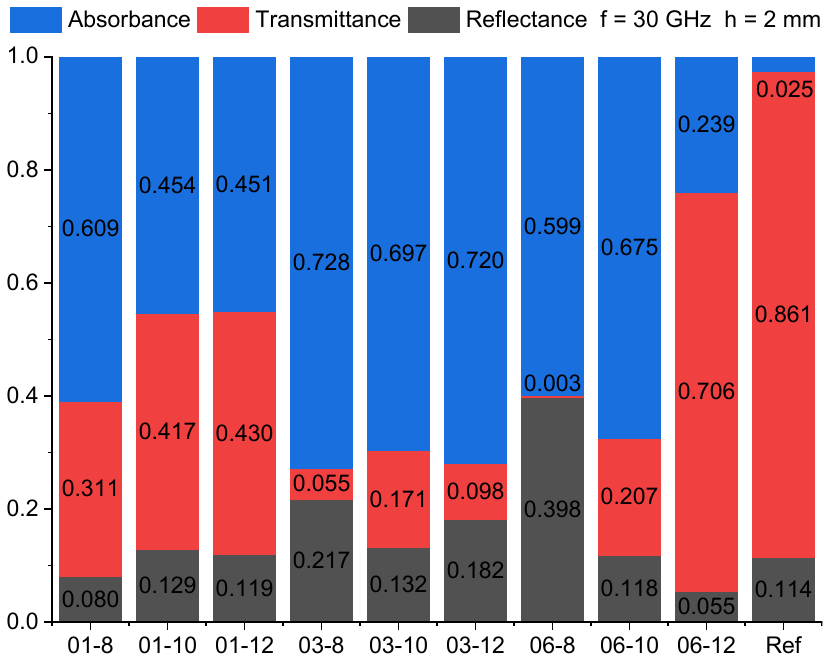
Figure 9. PBS hybrid nanocomposite EM absorbance, transmittance, and reflectance at 30 GHz for 2 mm ‐ thick samples.